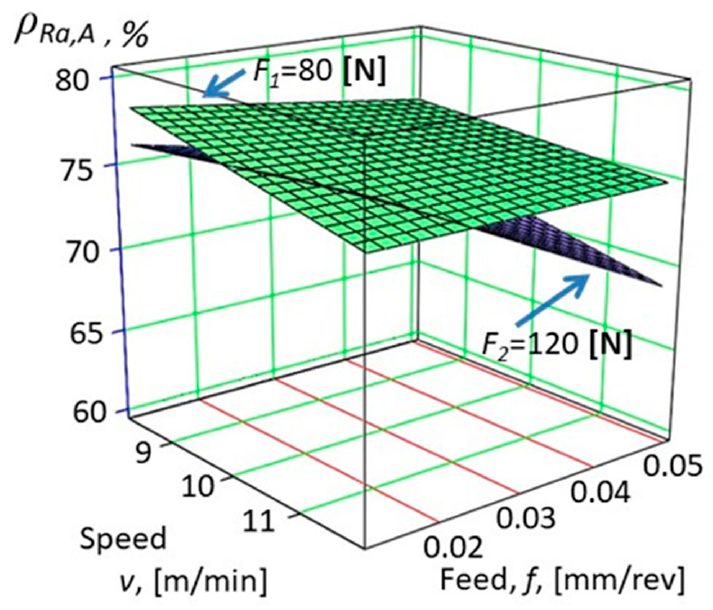
Figure 5. Improvement of the change of surface roughness ρ Ra , A on specimens marked A (see Equation (3)).